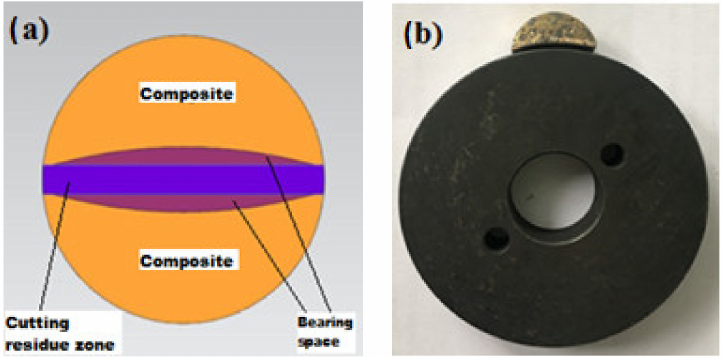
Figure 2. The samples used in the wear experiments: ( a ) composite materials and ( b ) abrasive disc. While bringing the MMC to this geometry, a CNC was used with a thickness of 10 mm and an inner radius of 69.05 mm, and then the inner surfaces were grinded, and a suitable surface structure was obtained. Due to the macro scale of the MMC components, block-on disc wear tests were carried out on the device shown in Figure 3, observing the